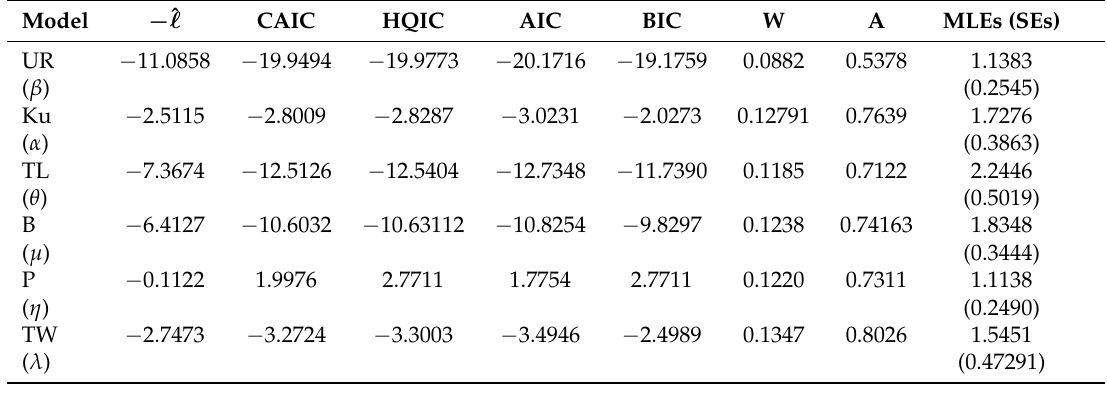
Table 4. Criteria and goodness-of-fit measures, MLEs and SEs for the flood level data set.